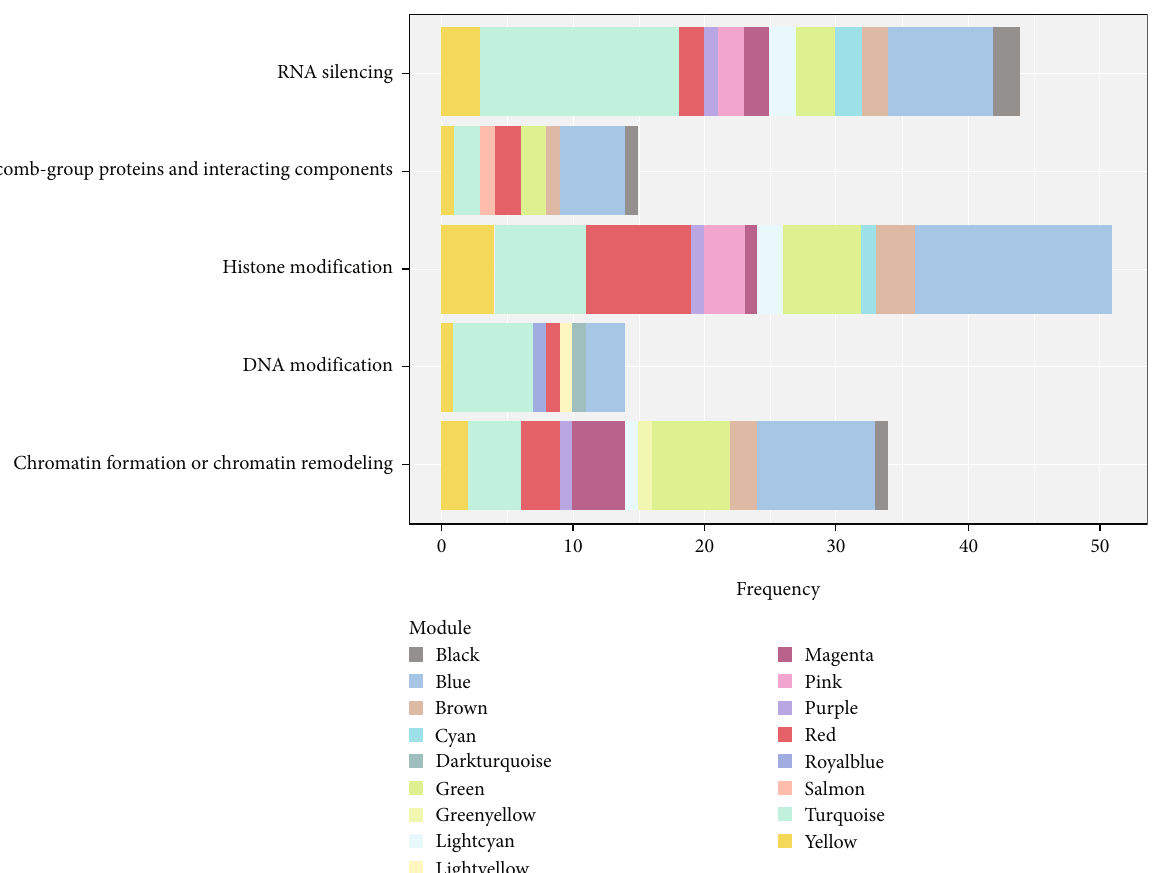
Figure 12: Distribution of genes encoding epigenetic regulators across the network